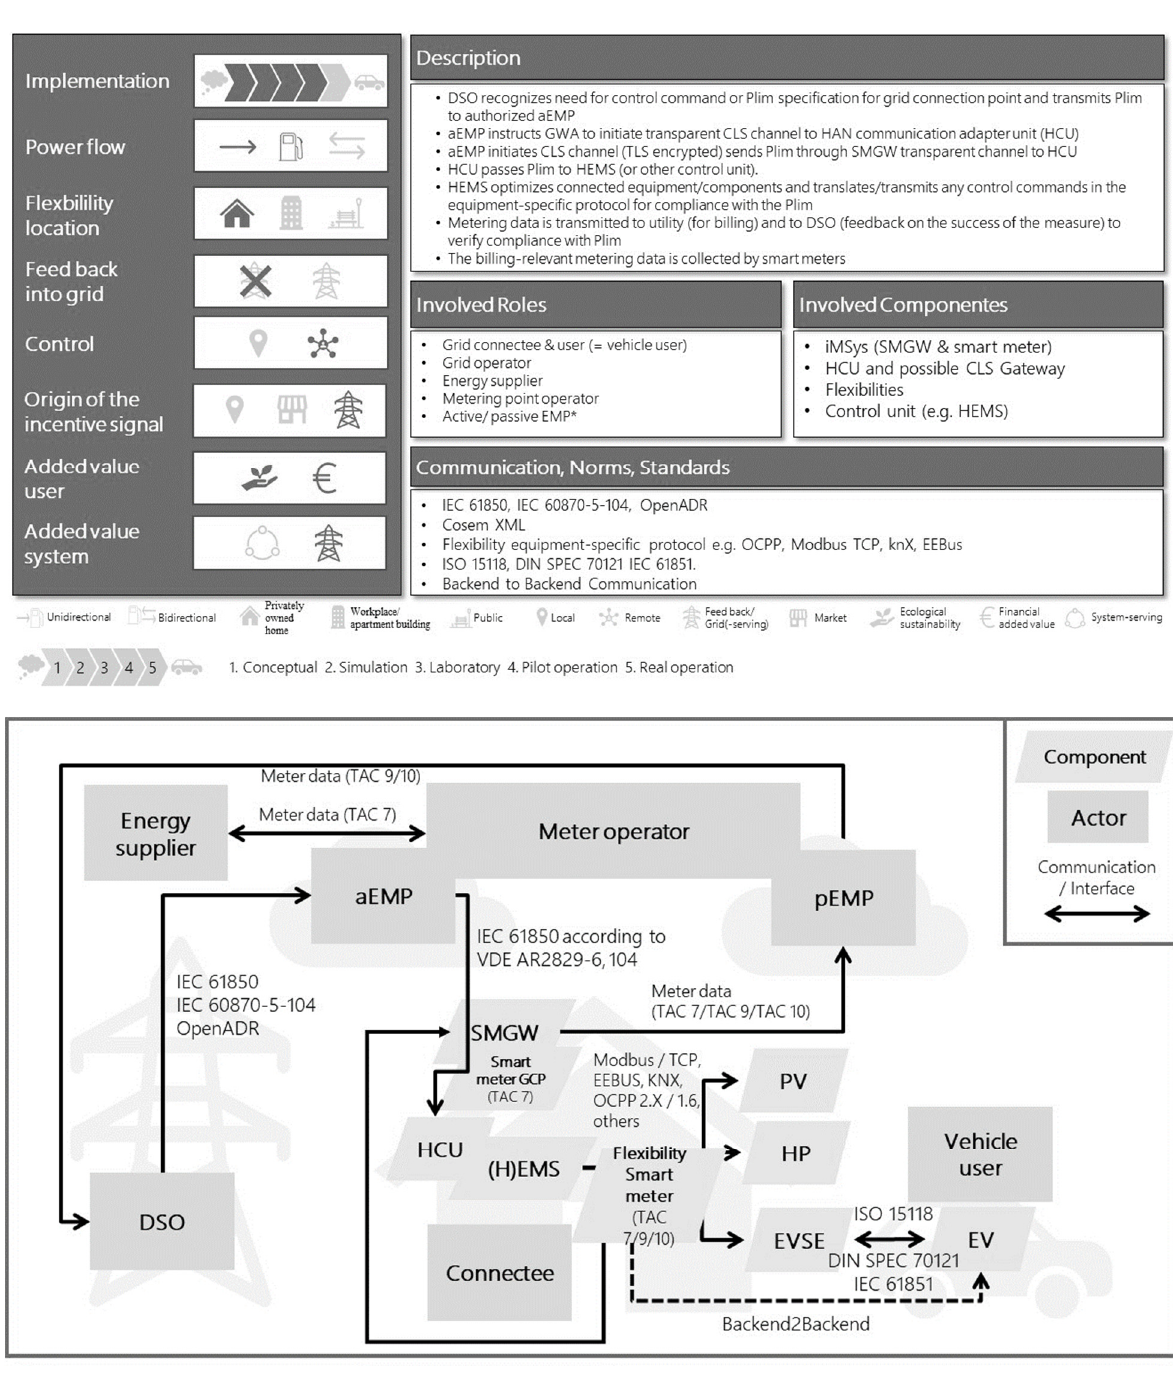
Figure 4. TUC regulatory-defined grid-serving unidirectional flexibility for privately owned home: description template ( top ) and e3-value model ( bottom ).